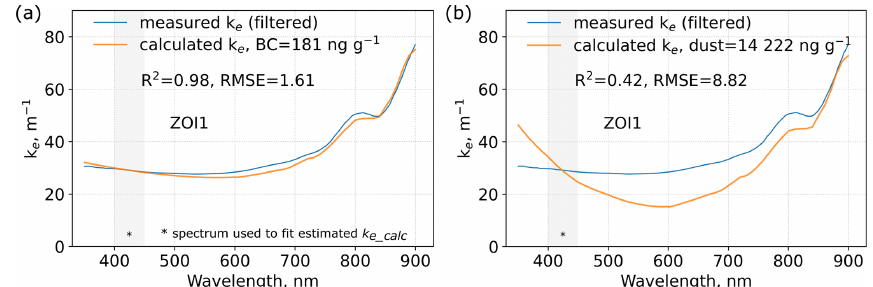
Figure 4. Example for measured and calculated absorption coefficient k e for a snowpack without shrubs. Measured k e was determined from SOLEXS measurements taken on 8 November (ZOI1). Calculated k e was computed with either (a) black carbon (BC) or (b) mineral dust as impurity type in the snowpack. The concentration of dust or BC was determined with an iterative approach, where calculated k e was fitted to the measured k e . This example shows how assuming BC as impurity type returns significantly better fits.